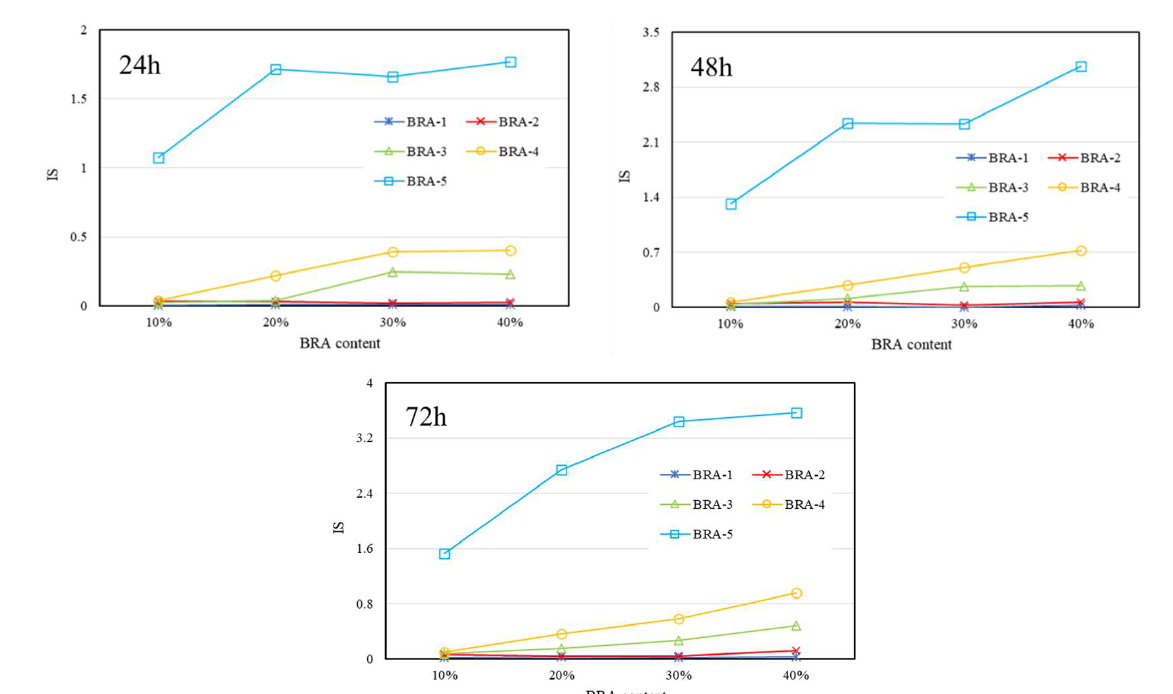
Figure 17. IS of BRA-MA after the segregation process at 145 °C.